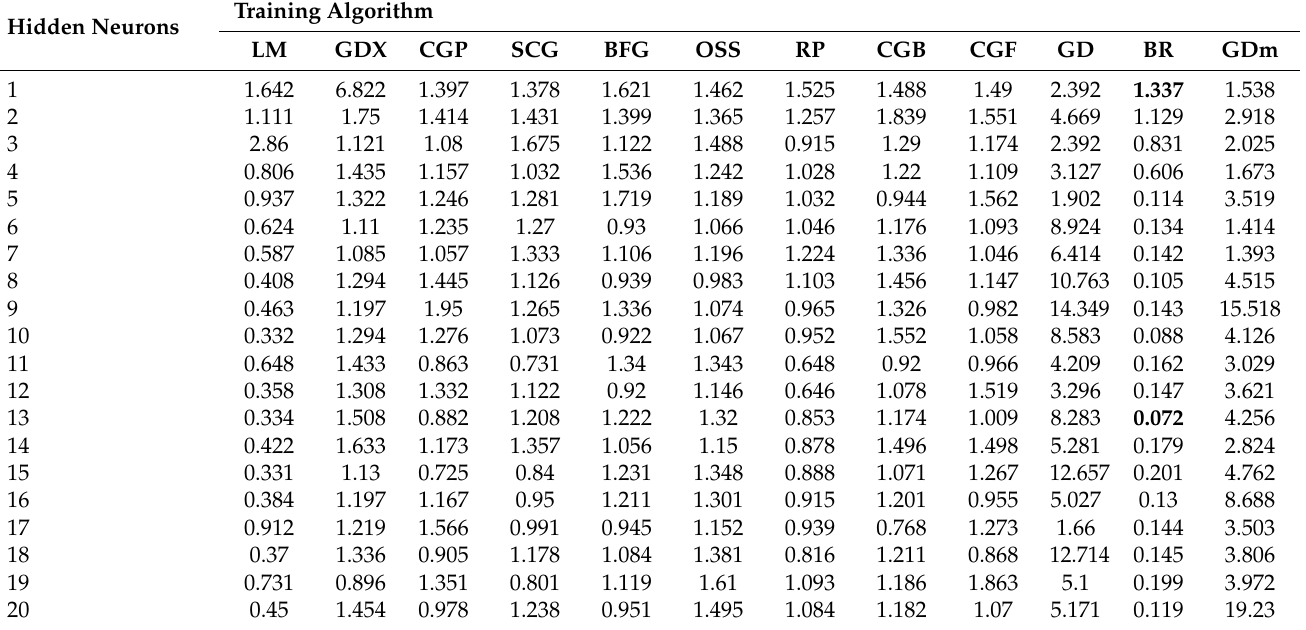
Table A12. MAE for percentage of CH4 in biogas for different training algorithms at different number of hidden